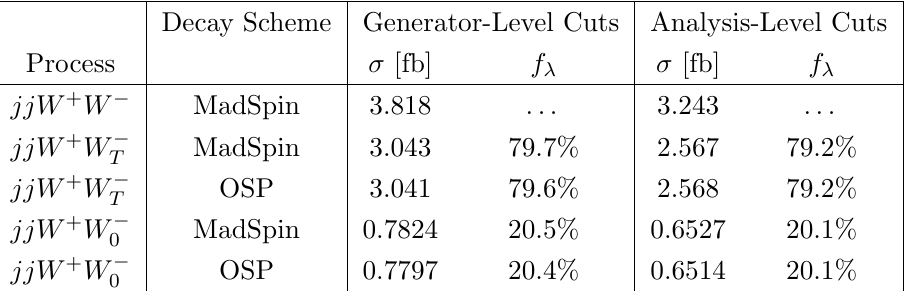
Table 3. Cross sections [fb] and polarization fractions ( f (cid:21) ) [%], of the pure EW process pp ! jjW + W (cid:0) , with W + ! (cid:22) + (cid:23) (cid:22) and W (cid:0) ! e (cid:0) (cid:22) (cid:23) e , in the SM for unpolarized W + and W (cid:0) helicity (cid:21) (cid:21) polarization (cid:21) , de(cid:12)ned in the p-CM frame, assuming generator- and analysis-level cuts of eq. (4.15) and eq. (4.23), and using the MadSpin and OSP decay schemes for W (cid:6) . decayed using MadSpin . As described in appendix A.2, the MadSpin syntax is the same for unpolarized and polarized W . Therefore in the madspin card.dat (cid:12)le, one only (cid:21)